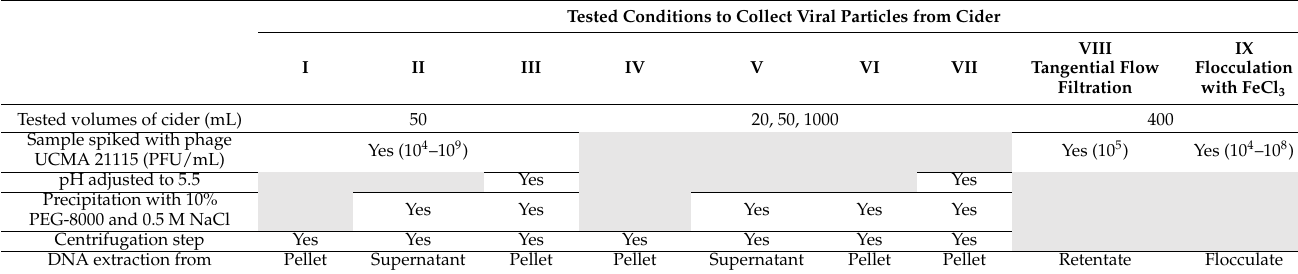
Table 2. Overview of the conditions tested for the collection of the phageome from cider. Roman numerals from I to IX indicate methodological steps referred to in the